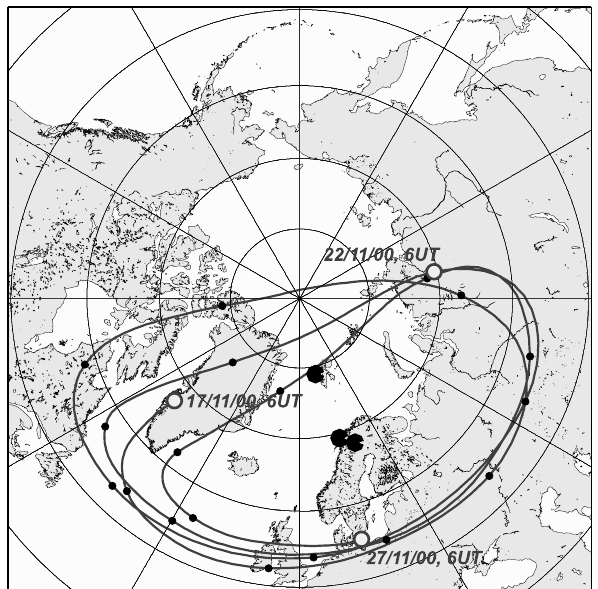
Fig. 5. Ten-day forward trajectory of the air parcel positioned above Søndre Strømfjord on 17 November 2000, 06:00UT, at about 38km altitude. The trajectory is calculated on the 1250-K-isentropic level. Markers indicate every 12h; circles are at 10 ◦ latitude distance.